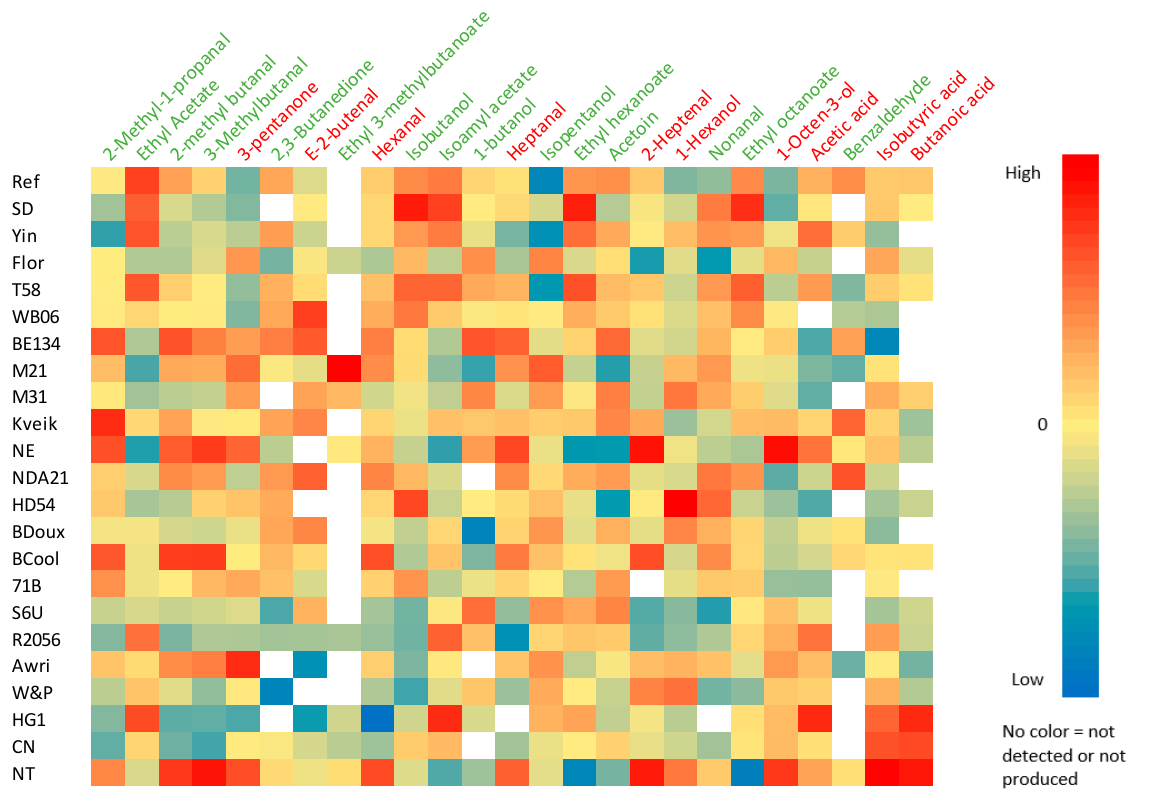
Figure 4. Heatmap illustrating the differences in relative concentrations of volatile compounds, as indicated by contrasting color codes (listed on the right), in sweet dough (14% sugar, w / w dm flour) prepared with 23 different yeast strains. Data are based on HS-SPME-GC-MS analysis of three biological replicates. For each column, the values shown in the heatmap are z-scores calculated from the average log2 relative peak areas (i.e., how many standard deviations any given value deviates from the mean of the column) and show if a certain strain produced a lower (blue tainted boxes) or higher (red tainted boxes) amount of a certain volatile compared to the mean value of that volatile compound. The compounds in green text are considered compounds with a positive aroma in bread, while the compounds in red text are considered off-flavors in bread.